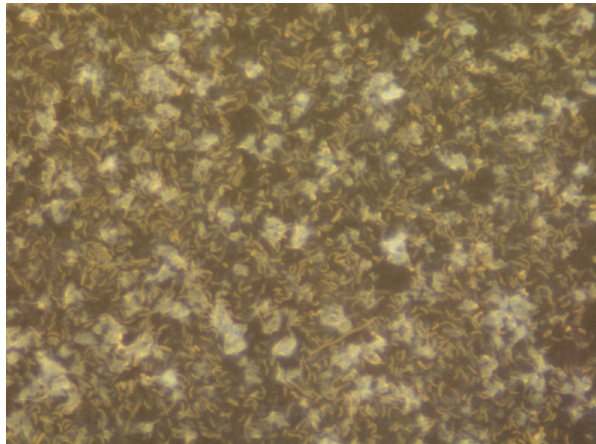
Figure 1: The crude culture of intestinal SRB isolated from a mouse with ulcerative colitis (magnified 10,000 ×).